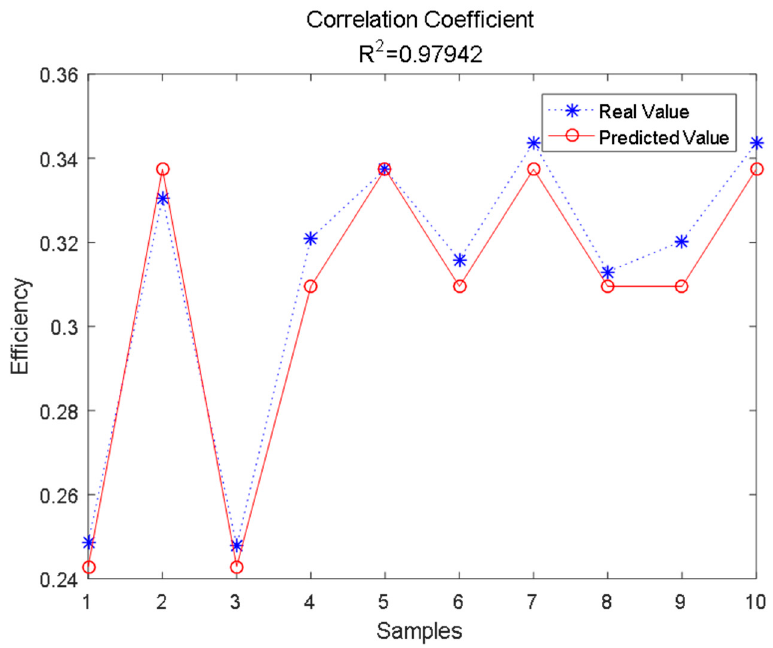
Figure 10. Efficiency predicted value by BP with learning rate optimization ( η = 0.3924).